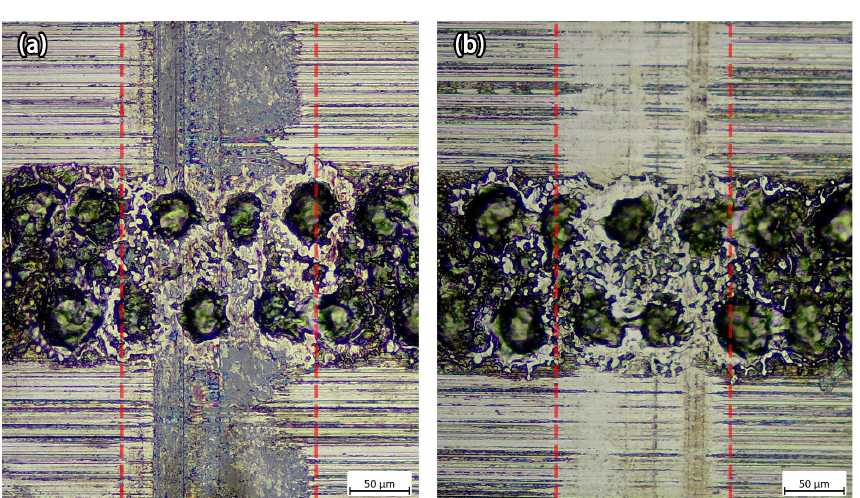
Figure 6. The textured workpiece after the sliding tests for both ( a ) dry and ( b ) lubricated conditions (normal load: 11.0 N; dimple density: 63%; magnification: